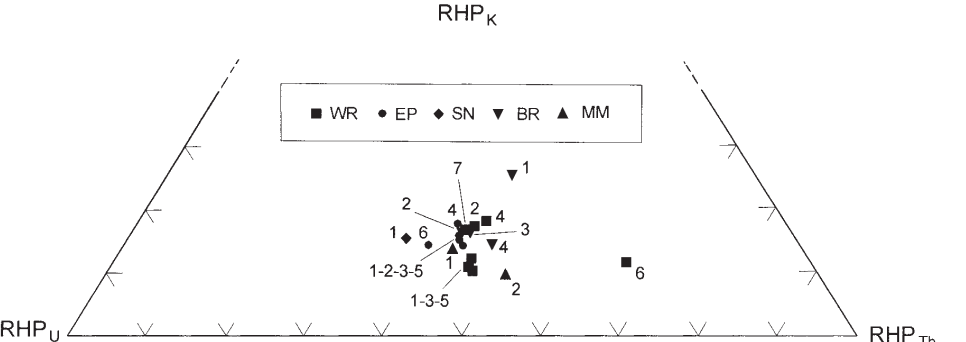
Fig. 5. Relative contribution of U, Th and K to the radioactive heat-production